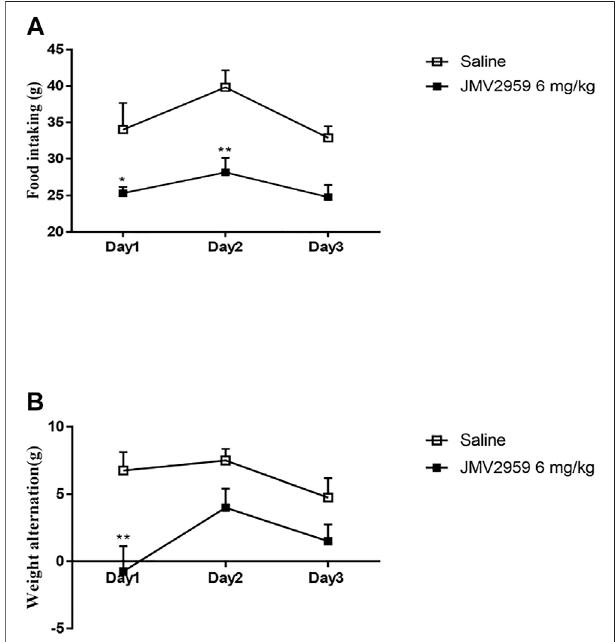
FIGURE 4 | Effect of JMV2959 on food intake and body weight. Weight alteration and food intake test were measured as described in methods. The difference between saline group ( n (cid:1) 6) and the group with JMV2959 (6 mg/kg, n (cid:1) 6)wererecordedby (A) food intaking and (B) body weight in 3 days. Two-way repeated measures ANOVA was taken. Values are presented as the mean ± SEM ( n (cid:1) 4).* p < 0.05,** p <